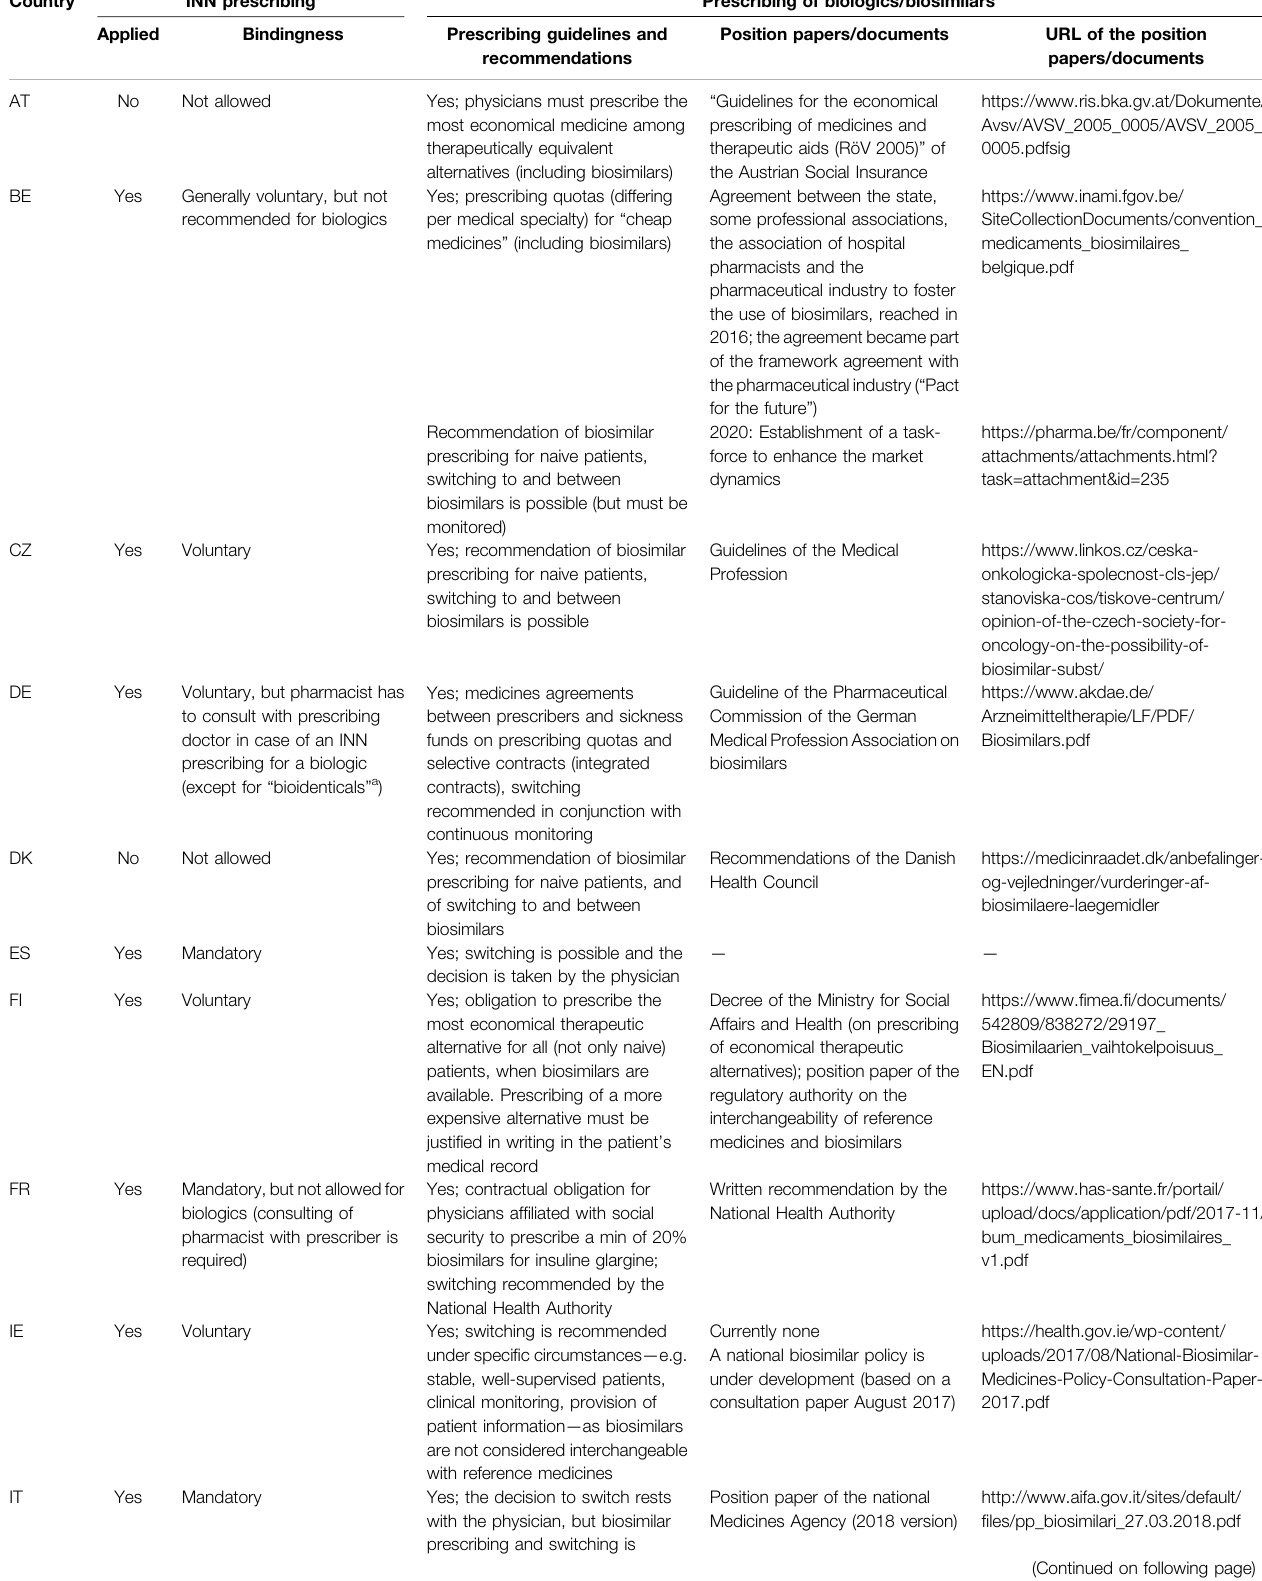
TABLE 4 | Measures to foster biosimilar prescribing aimed at